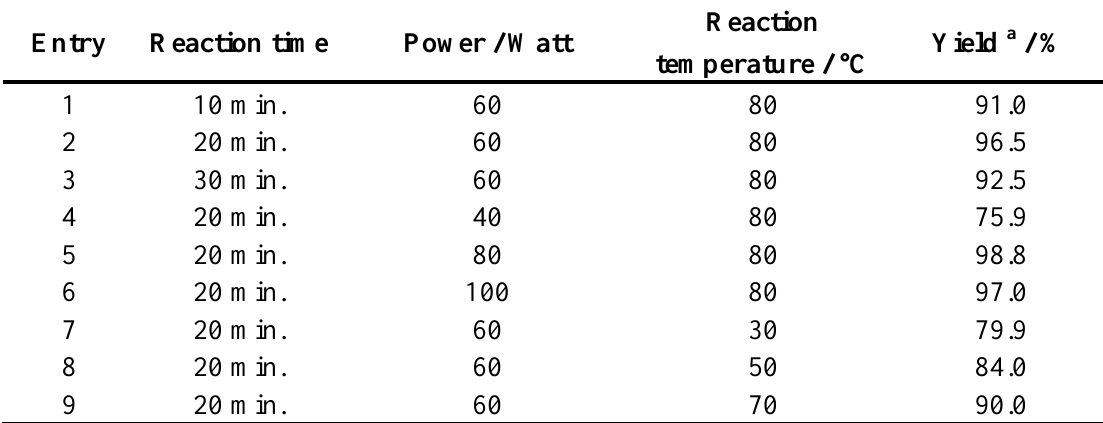
Table 2. Different conditions used for the microwave assisted synthesis of 5b